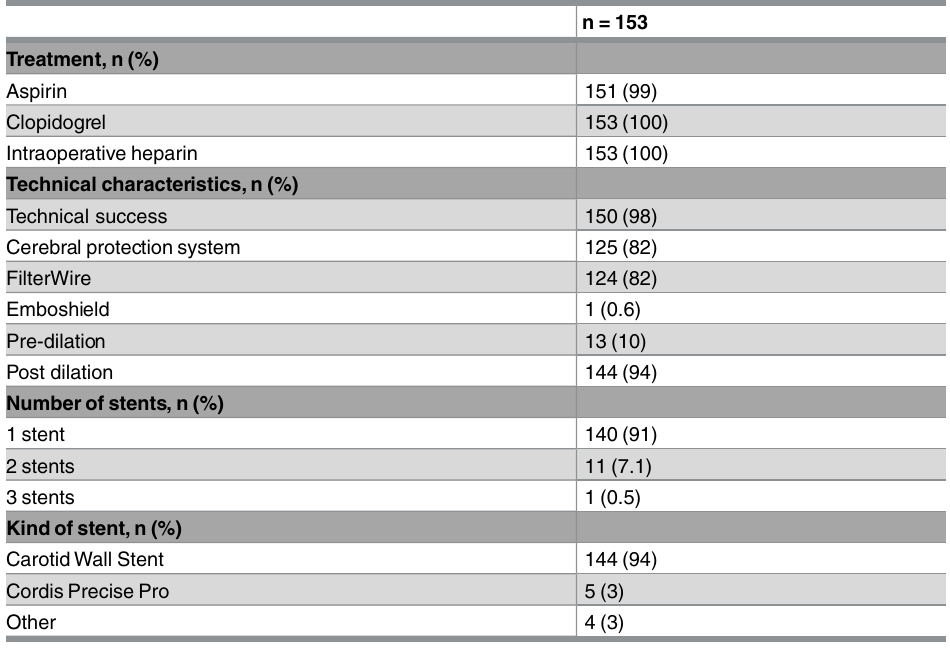
Table 2. Procedural